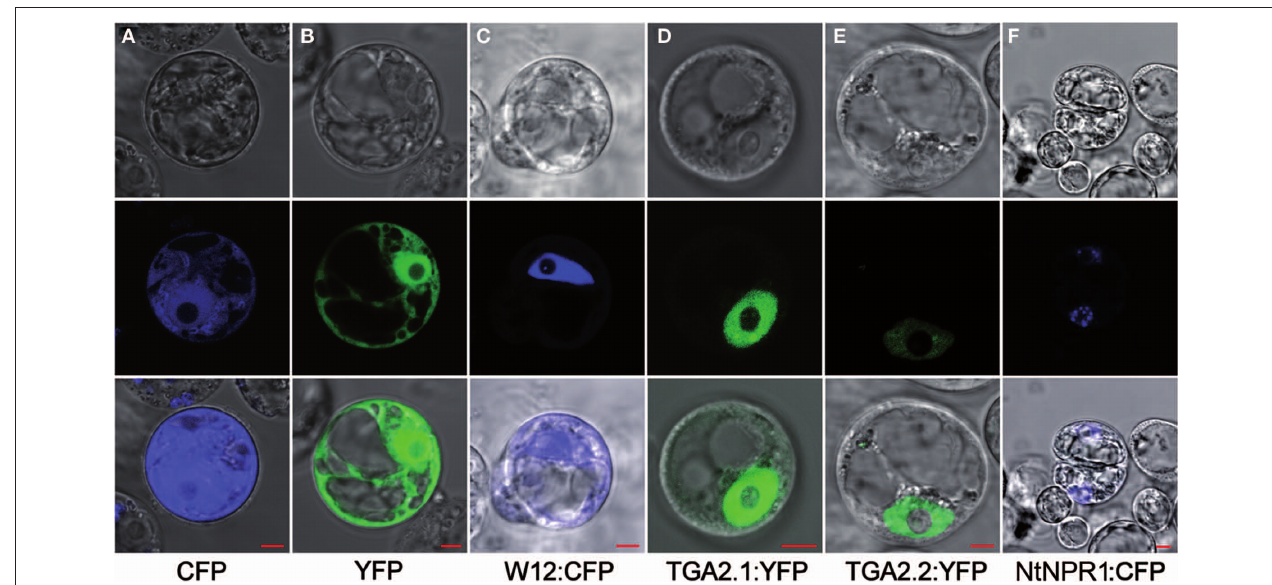
FiGuRe 1 | Nuclear localization of NtWRKY12 and TGAs. The panels on the middle row show confocal laser scanning microscopy images obtained of Arabidopsis protoplasts transfected with expression plasmids encoding unfused CFP (A) and YFP (B) , and fusion proteins NtWRKY12:CFP [ (C)